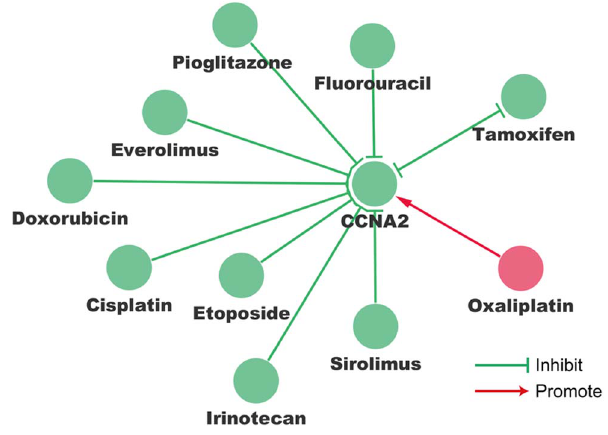
Figure 2. Interaction network of CCNA2 and chemotherapeutic drugs. The gene-drug interaction network shows us how available chemotherapeutic drugs could decrease the expression of CCNA2. For example, Doxorubicin could decrease the expression of CCNA2, while Oxaliplatin could increase the expression of CCNA2.